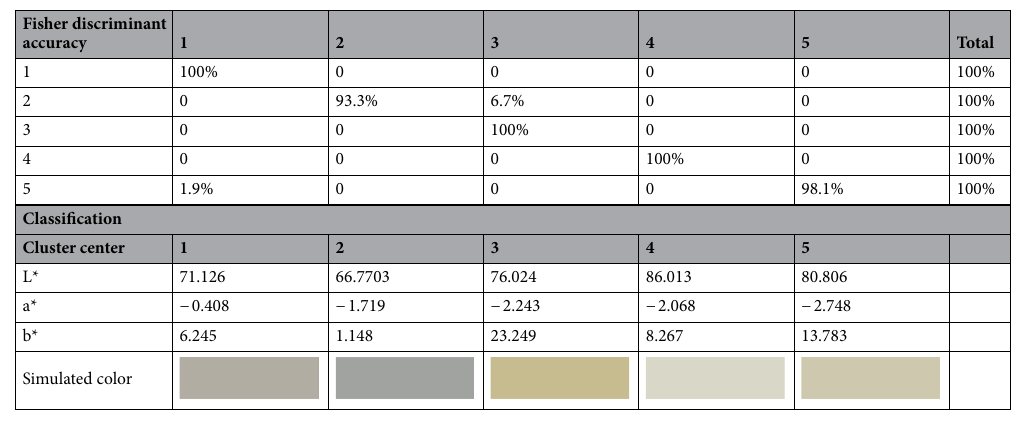
Table 5. Cluster center and Fisher discriminant